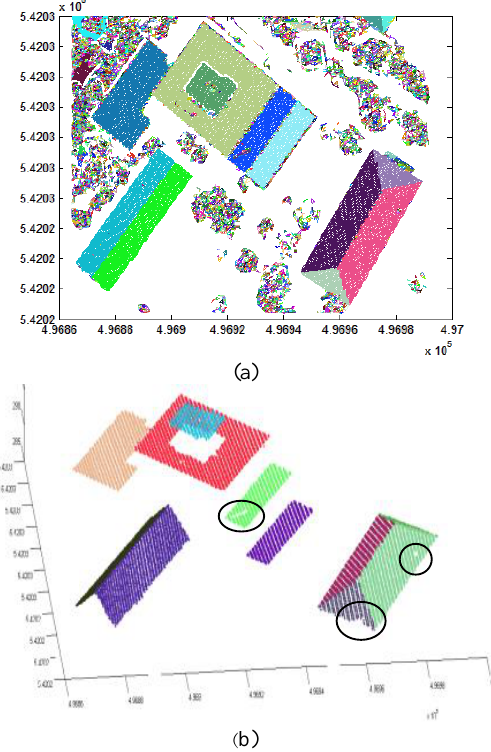
Figure 4. a) Segmented triangles, b) Building segments points